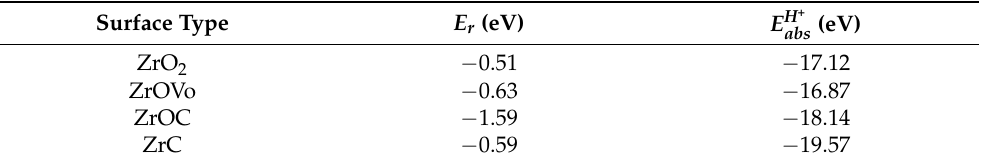
Table 4. Dissociation energy E r of the water molecule and absorption energy E abs H + of H+ on the ZrO 2 ( − 111) surface, ZrO 2 ( − 111) surface with an oxygen vacancy (ZrOVo), ZrO2 ( − 111) surface with an oxygen vacancy occupied by C (ZrOC), and the ZrC (111) surface.